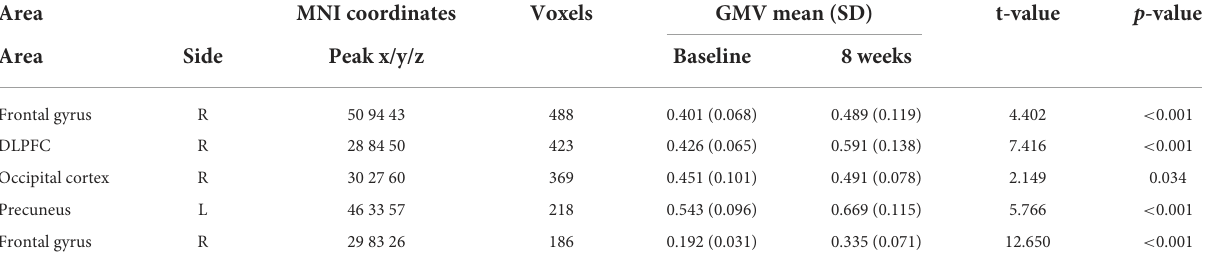
TABLE 4 Main regions showing gray matter volumes alterations in patients with MMD (clusters > 50 voxels).